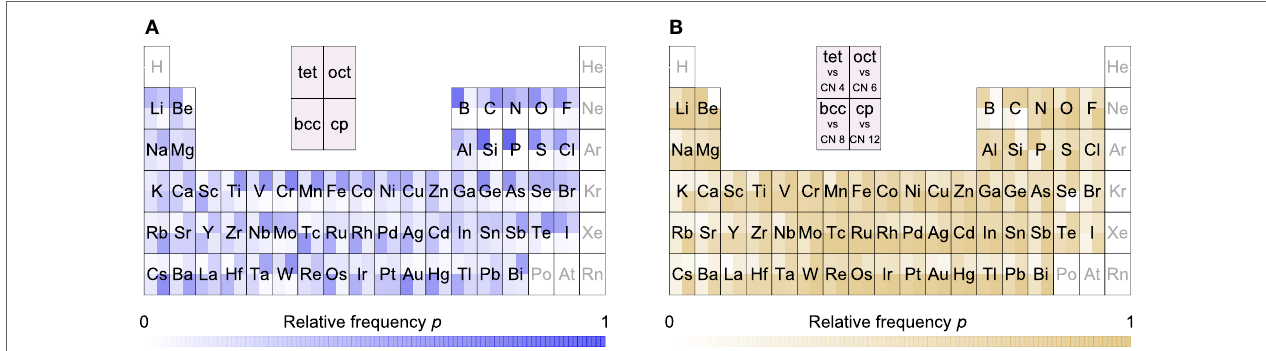
FIGURE 8 | (A) Relative occurrences of motifs (tetrahedra, octahedra, bcc-like, and close packed) for each element in the Materials Project (MP) database; (B) relative occurrence of each recognizable motif (e.g., tet) to all local environments with the corresponding coordination number (e.g., 4). Note that each site contributes with a factor of 1/ N sites , where N sites denotes the total number of sites (atoms) found in the primitive unit cell of the material in question (i.e., the frequencies are materials weighted, not site-weighted). Also, note that we filtered out 9% of the MP structures because we discarded noble gas-containing materials and materials that seem very unstable (energy above the convex hull of 0.2eV per atom or more); in addition, we exclude the results for hydrogen sites. Section 1.2 in Supplementary Material lists how many sites of a given element were used for generating these figures.